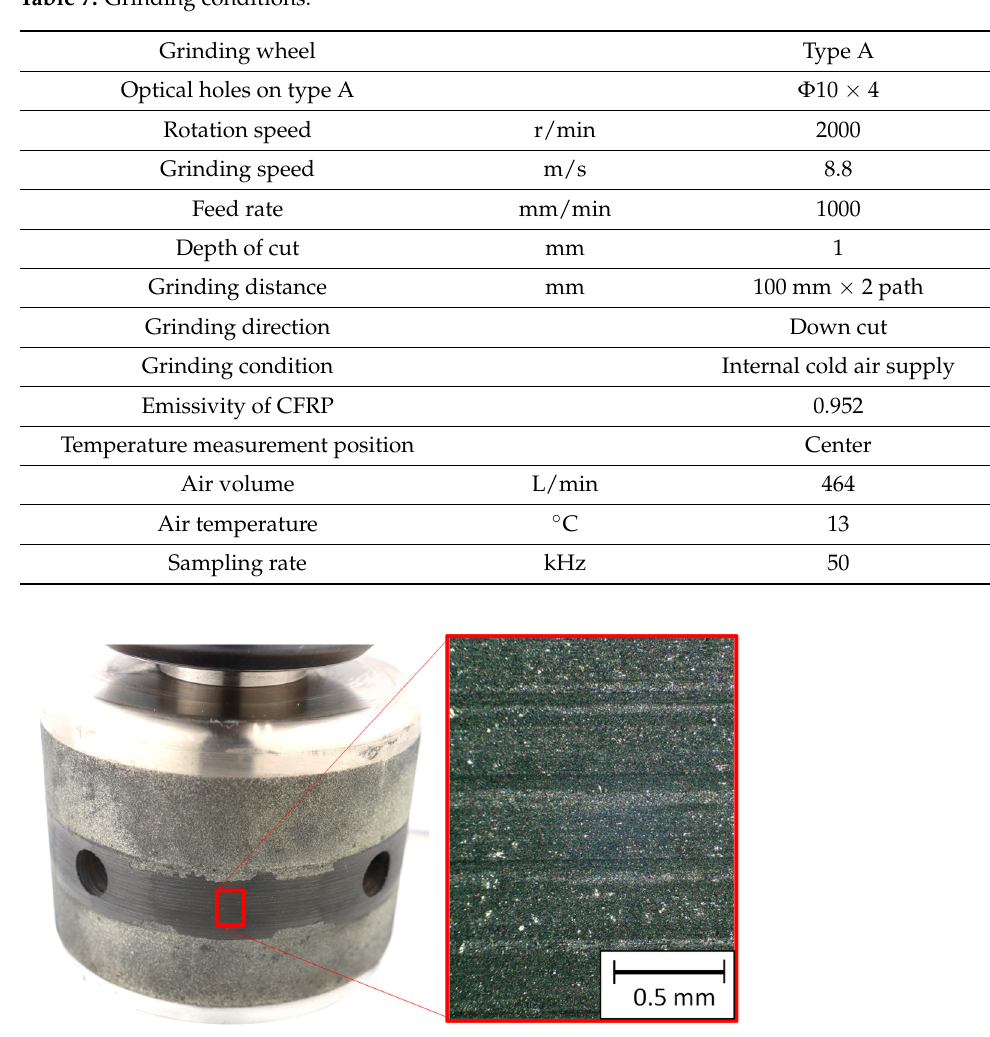
Figure 17. Grinding wheel after machining.